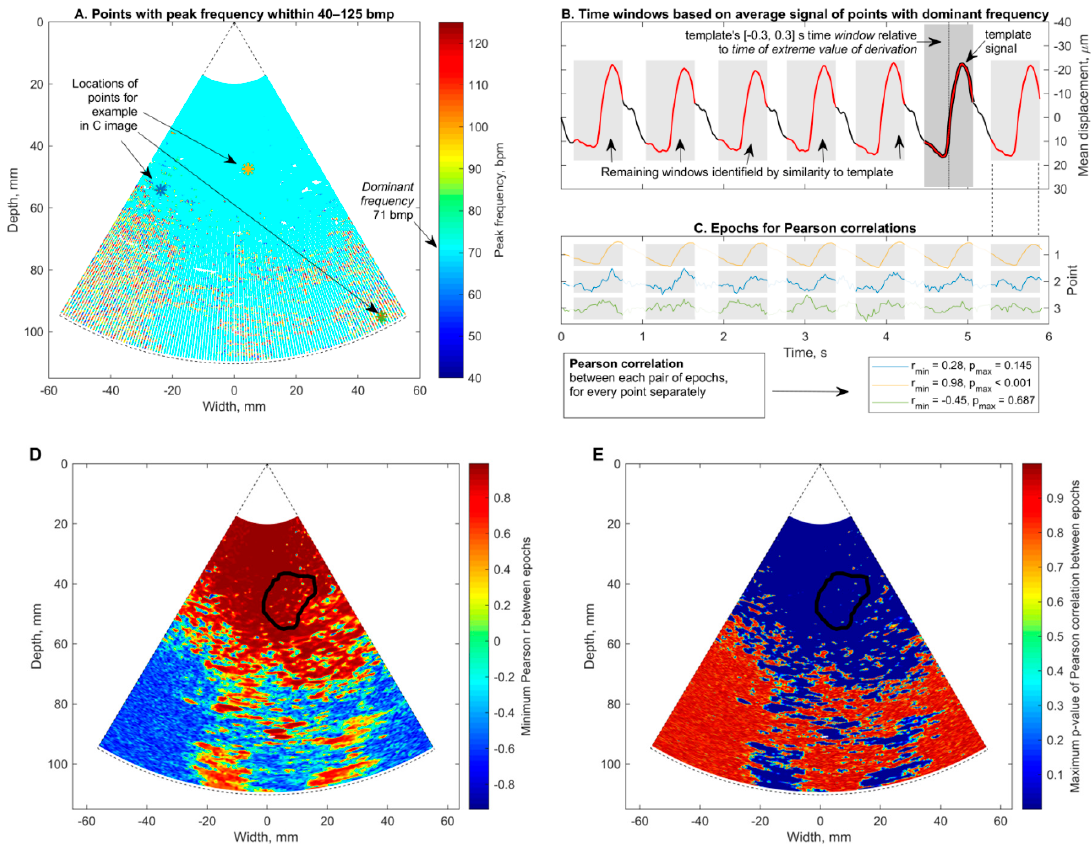
Figure 9. Displacement confidence evaluation by the Pearson correlation of accumulated displacements for a patient with Alzheimer’s disease. ( A ) Dominant frequency (here 71 BPM) determined as the most frequent value of peak frequency from points with spectral peak frequency within a 40–125 BPM interval; ( B ) epochs are time windows of similar waveforms in the average signal of points with dominant frequency; similarity was detected by reference-template matching technique, here seven epochs were identified; ( C ) Pearson correlation was calculated between each pair of signal segments from epochs that belonged to the same spatial point; here 7 × 6:2 = 21 pairs / correlations for every point. The minimum of Pearson correlation r ( D ) and maximum p -value ( E ) were used as the confidence criteria—the point was confident if minimum r > 0 and maximum p -value ≤ 0.01 from all 21 correlations for a particular point. In D and E the cross-sectional region of the hippocampus outlined with black solid line.